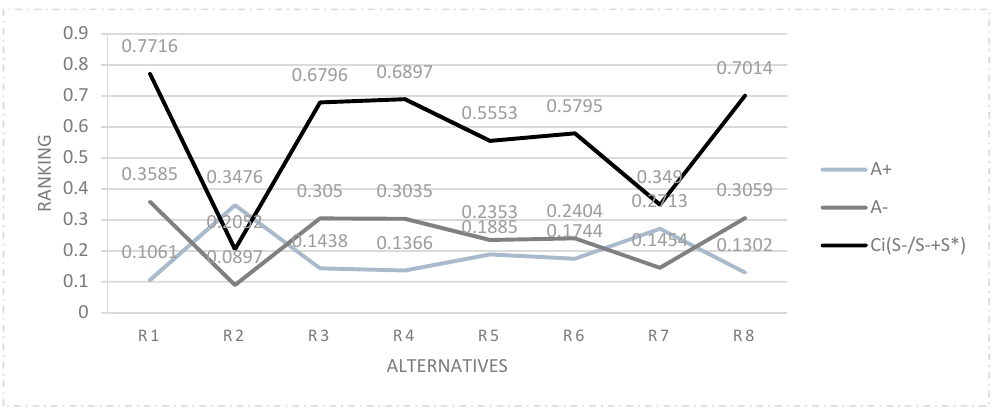
Figure 4. Alternatives’ rank.